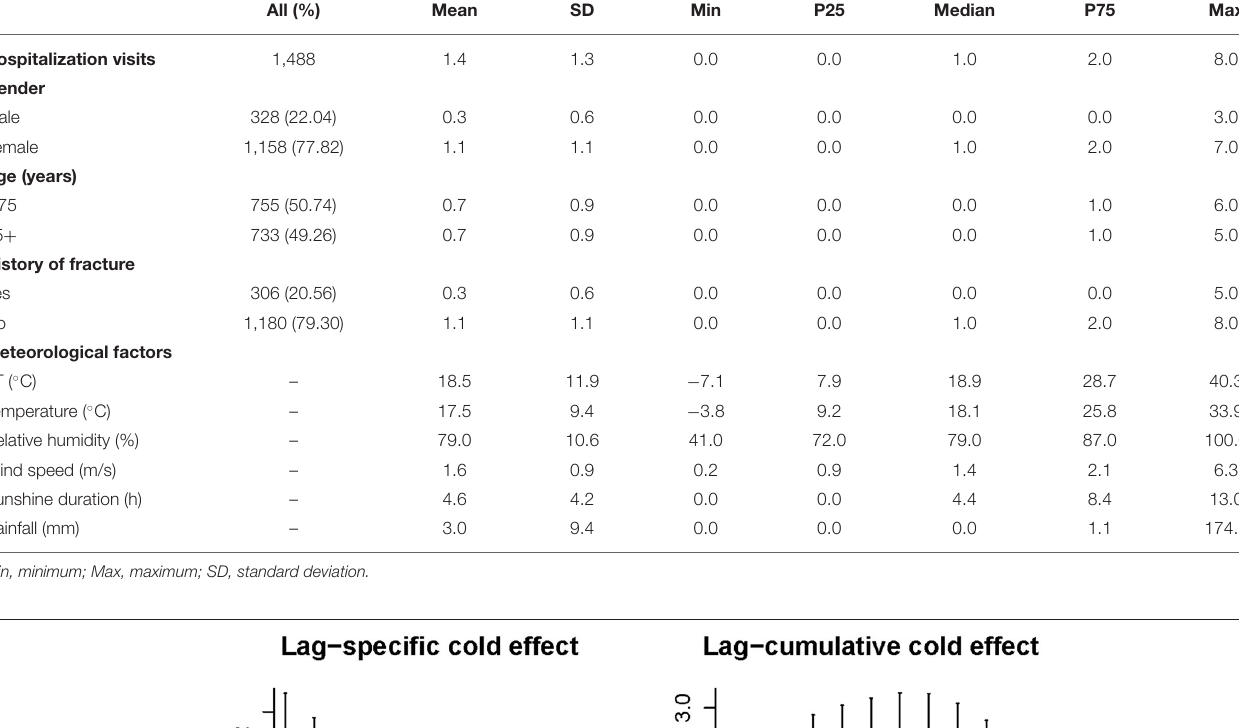
osteoporotic fractures were identified in single and cumulative lag days.